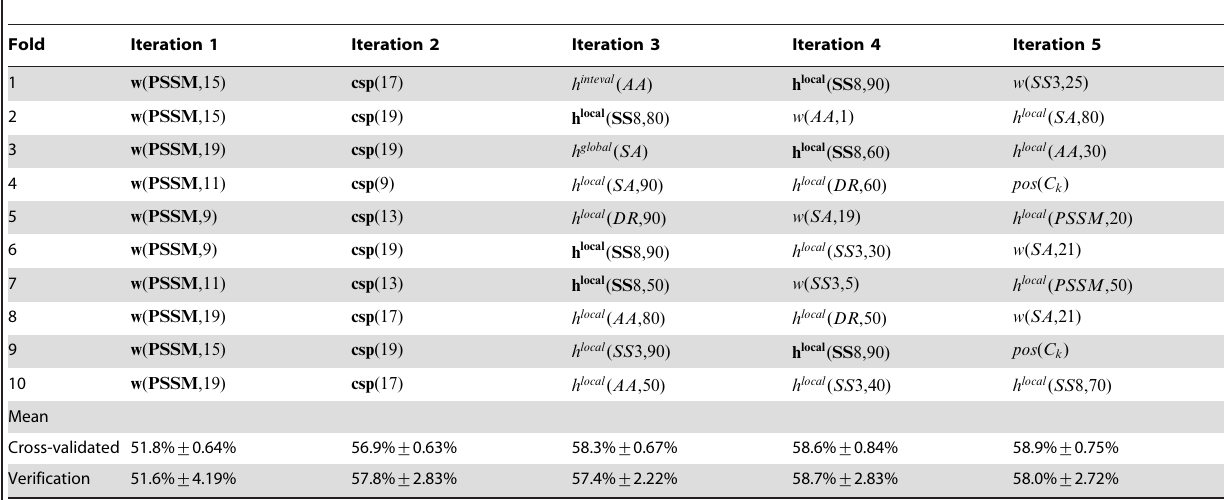
Table 4. Forward feature functions selection with 10 train/test splits of the SPX z dataset.